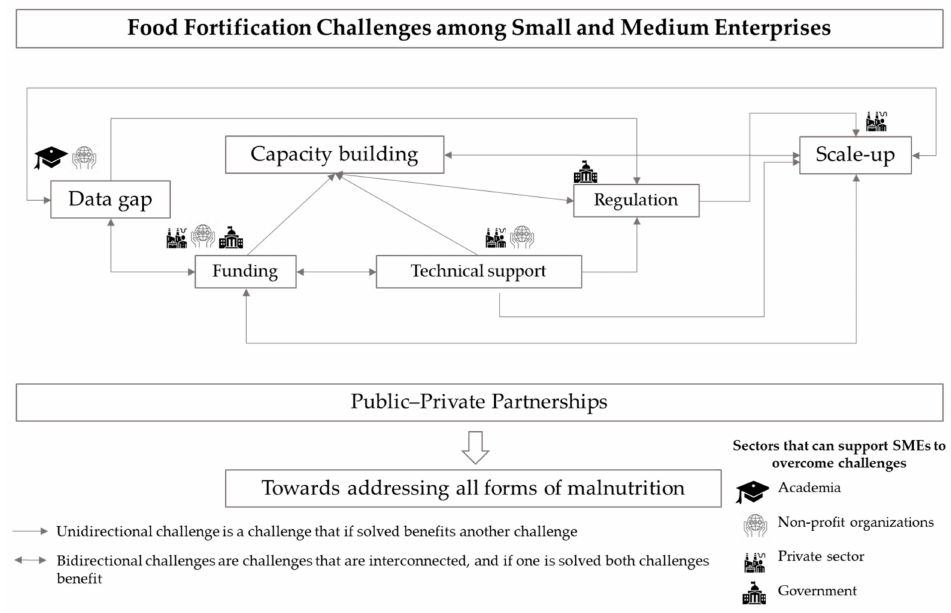
Figure 1. Overview of interconnected food fortification challenges and potential actors to overcome food fortification challenges towards the burden of